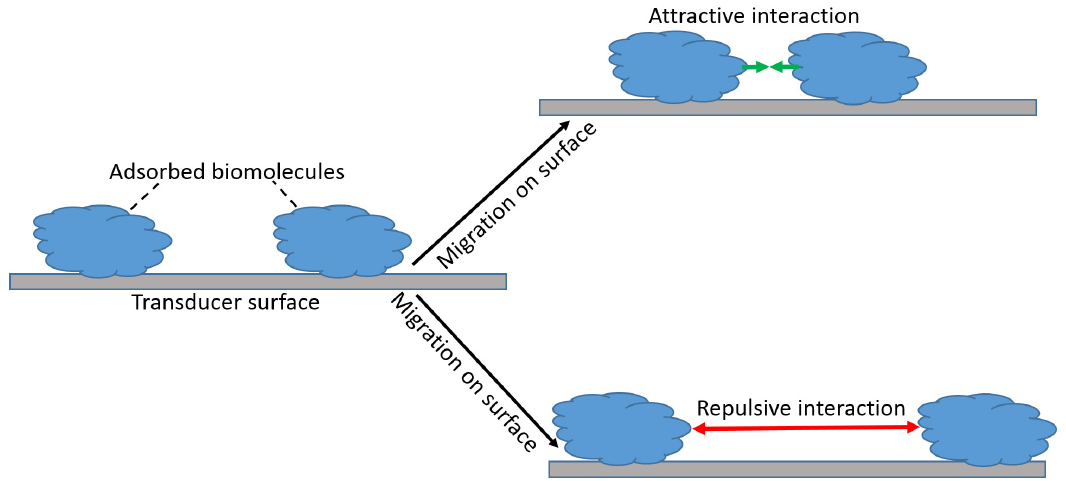
Figure 7. Migration of biomolecule adsorbate with attractive or repulsive interactions.